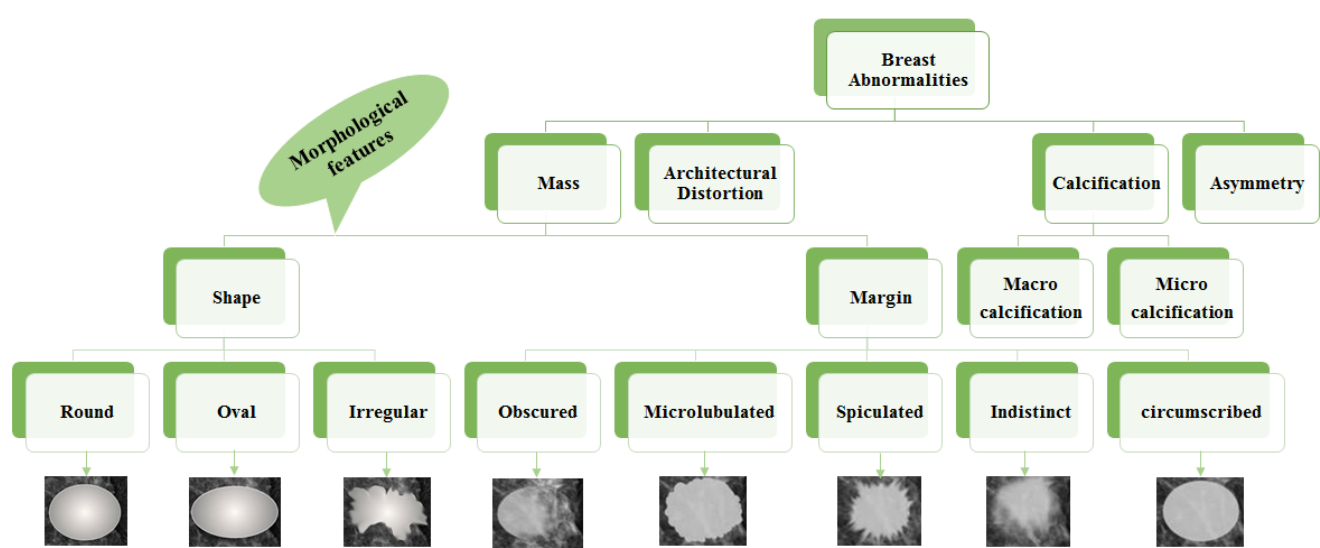
Figure 4. Taxonomy of breast abnormalities and morphological features in mammograms.